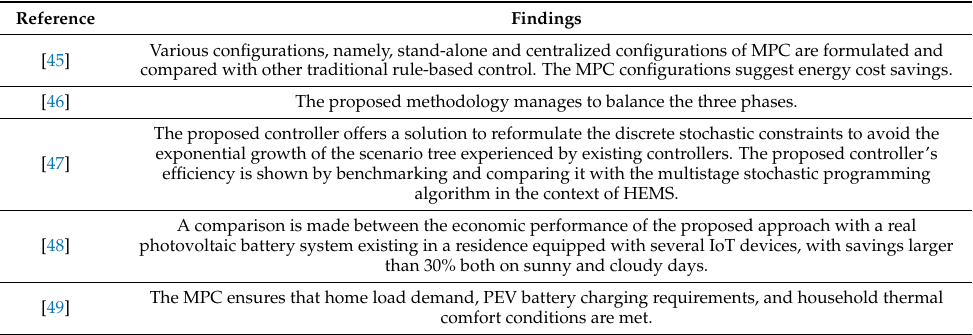
Table 13. Findings of selected papers associated with model predictive control.